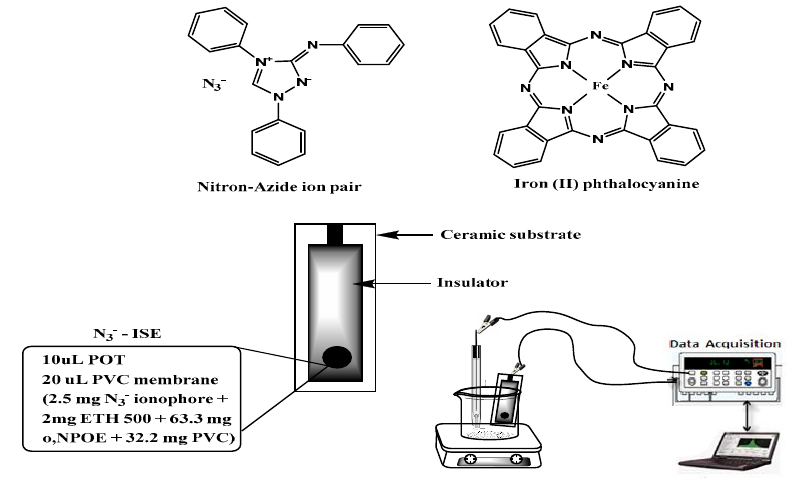
Figure 1. Chemical structures of azide ionophores used for azide membrane sensors and a schematic presentation of the proposed device.